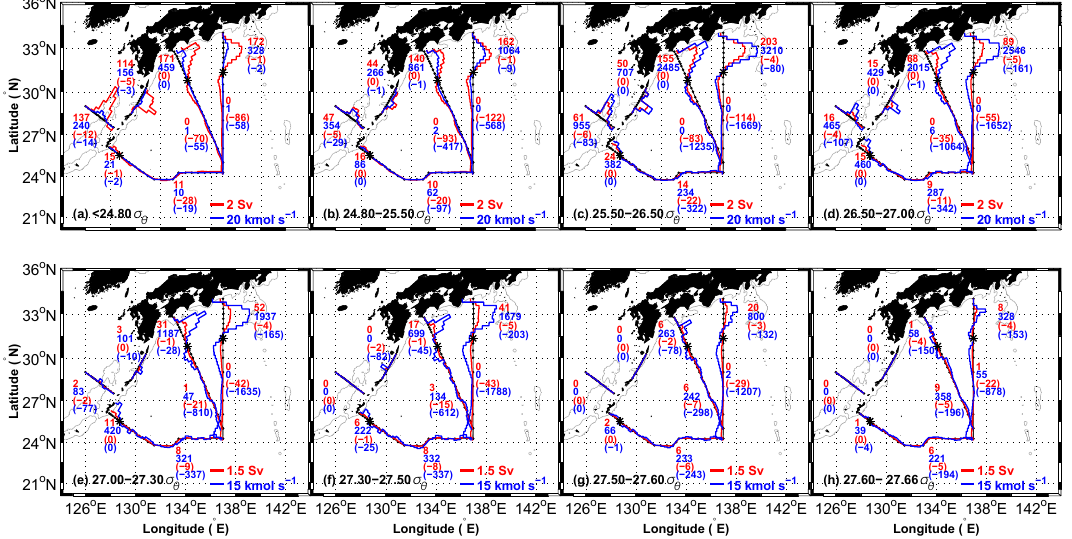
Fig. 5. The same as Fig. 1b, but for each of the eight isopycnal layers: (a) sea surface–24.8 σ θ , (b) 24.8–25.5 σ θ , (c) 25.5–26.5 σ θ , (d) 26.5–27 σ θ , (e) 27–27.3 σ θ , (f) 27.3–27.5 σ θ , (g) 27.5–27.6 σ θ , and (h) 27.6–27.66 σ θ